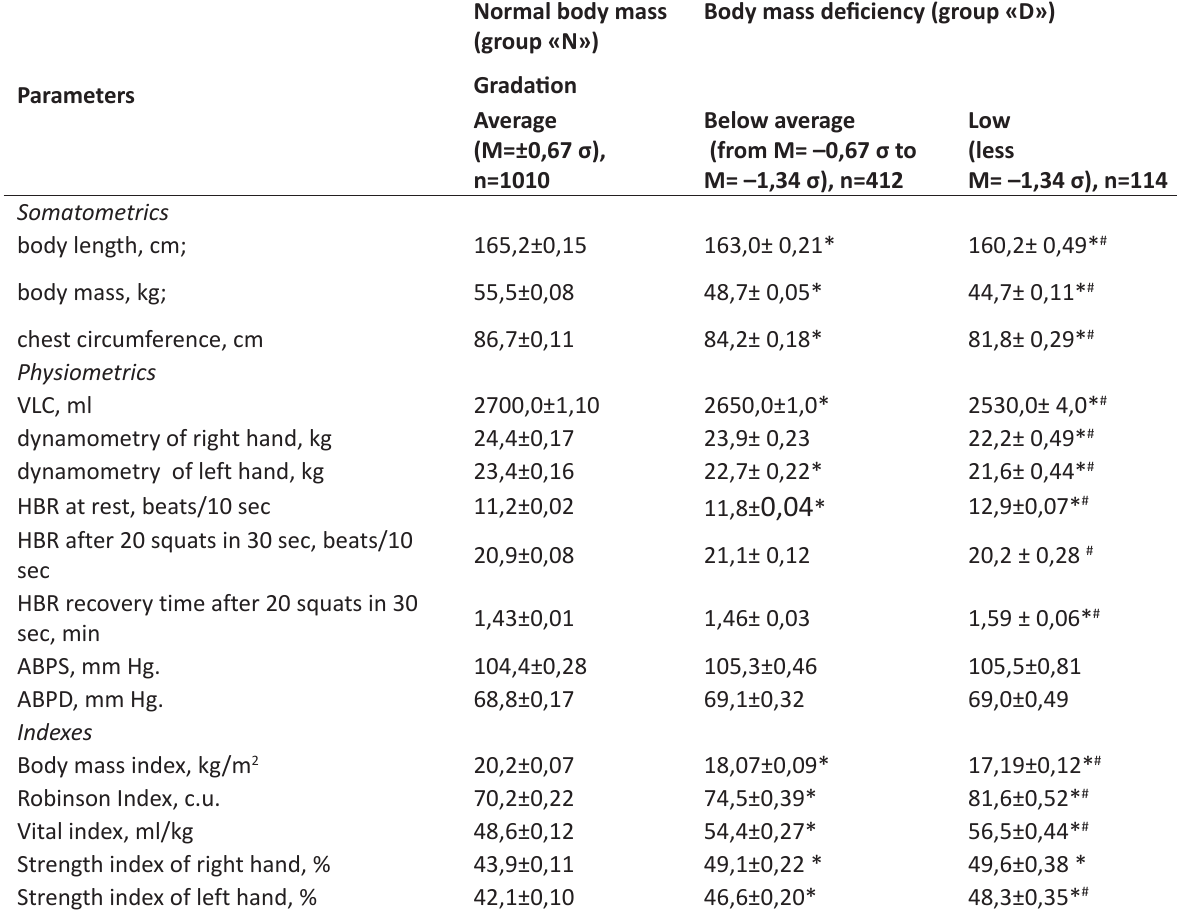
Table 1. Morphofunctional characteristics (М±m) of females with a different gradation of body mass parameter value